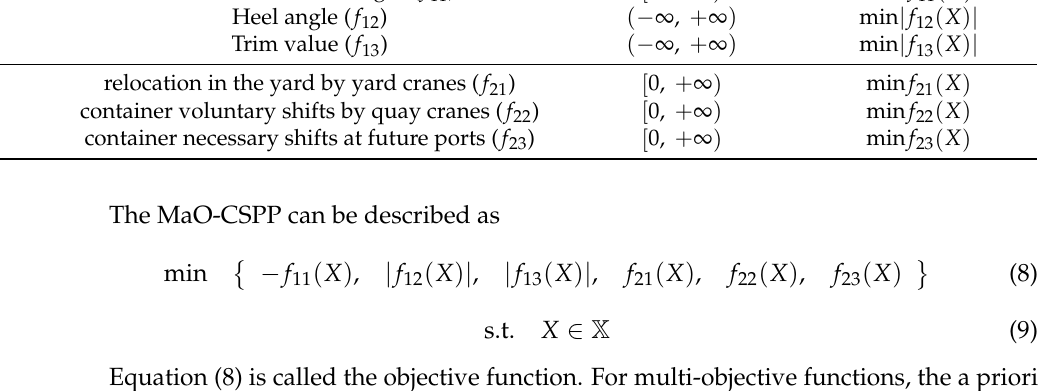
Table 2. The specific meaning of the six objective functions of the MaO-CSPP.